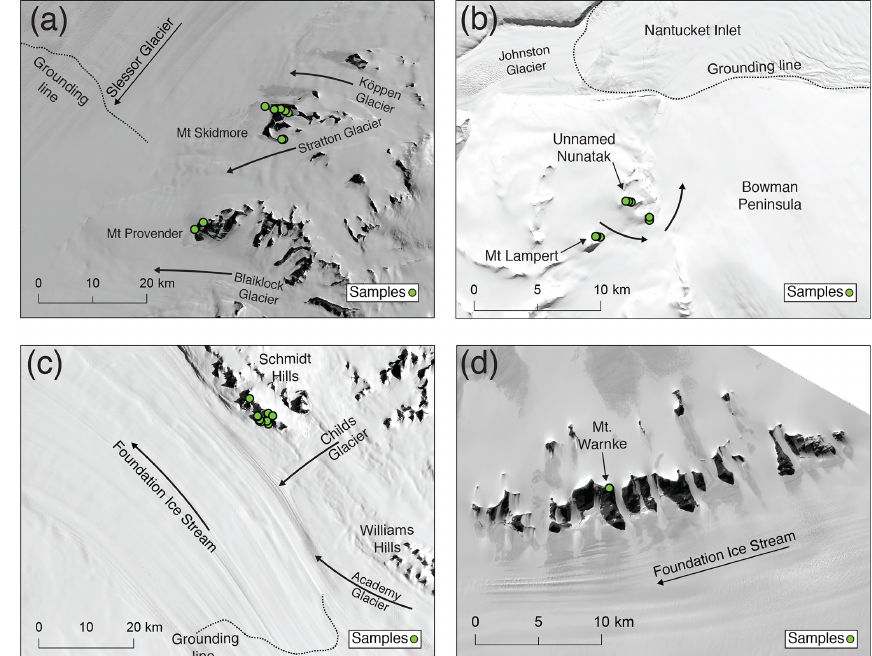
Figure 4. Landsat imagery of study sites. Location of each image is shown in Fig. 1. Green dots show sample locations. Arrows show ice flow directions. (a) Mt Skidmore and Mt Provender, Shackleton Range. (b) Lassiter Coast, southern Palmer Land. (c) Schmidt Hills, Pensacola Mountains. (d) Thomas Hills, Pensacola Mountains. Landsat 8 imagery courtesy of the U.S. Geological Survey. Grounding line positions sourced from the MEaSUREs program V2 (Rignot et al., 2011, 2014,